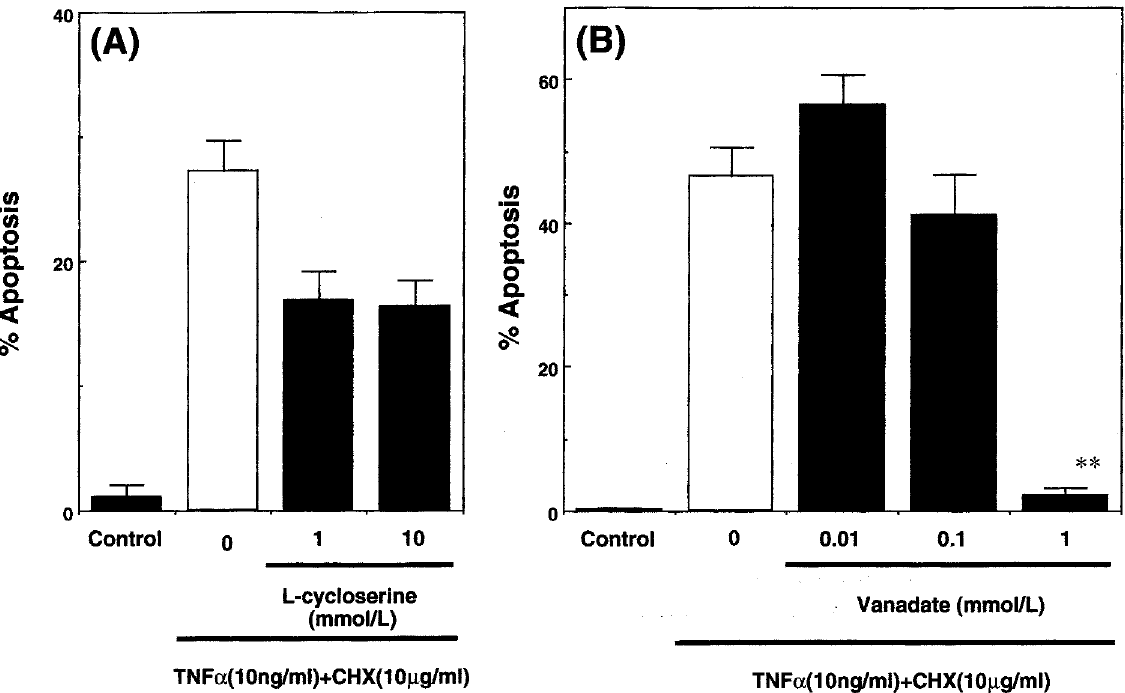
FIG. 3. Effects of L -cycloserine and vanadate on TNF a and cycloheximide-induced apoptosis of endothelial cells. (A) Endothelial cell monolayers were treated with TNF a (10ng/ml) and cycloheximide (10 m g/ml) in the presence or absence of L -cycloserine (1–10mmol/l) for 6h. After the incubation treatment, the cells were stained with propidium iodide, as described in Materials and methods. The percentage of apoptotic endothelial cells represents the number of apoptotic cells in the counted 100 cells (apoptotic cells+viable cells). The data show the mean±SEM for 10 wells. (B) Endothelial cell monolayers were treated with TNF a (10ng/ml) and cycloheximide (10 m g/ml) in the presence or absence of sodium vanadate (0.01–1mmol/l) for 6h. After the incubation treatment, the cells were stained with propidium iodide, as described in Materials and methods. The percentage of apoptotic endothelial cells represents the number of apoptotic cells in the counted 100 cells (apoptotic cells+viable cells). The data show the mean±SEM for 10 wells. ** P <0.01 versus TNF a and cycloheximide-treated value. Each experiment was repeated three